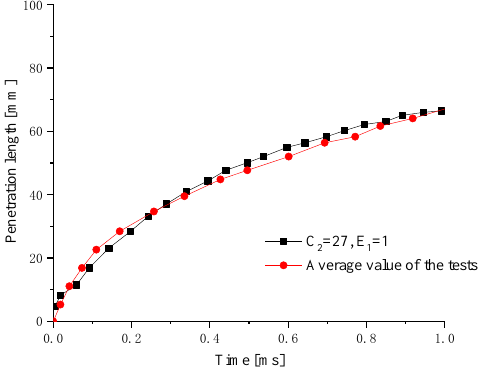
Figure 6. Comparison of the vapor penetration length between the simulated and experimental results for Case 1.